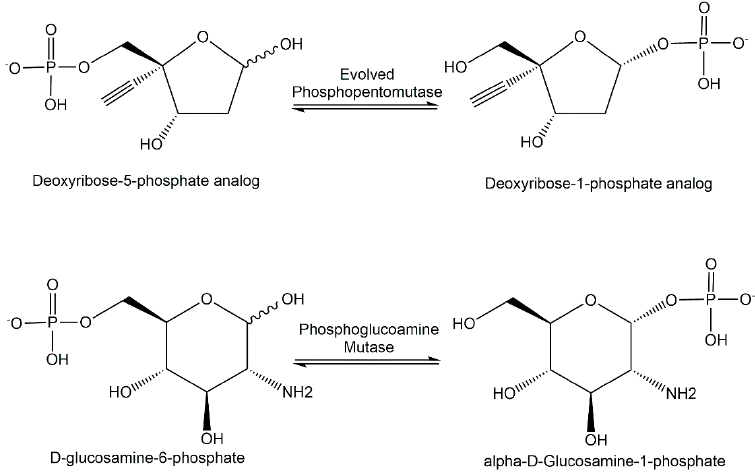
Figure 10. Novel phosphomutases for intramolecular phosphorylation reactions .